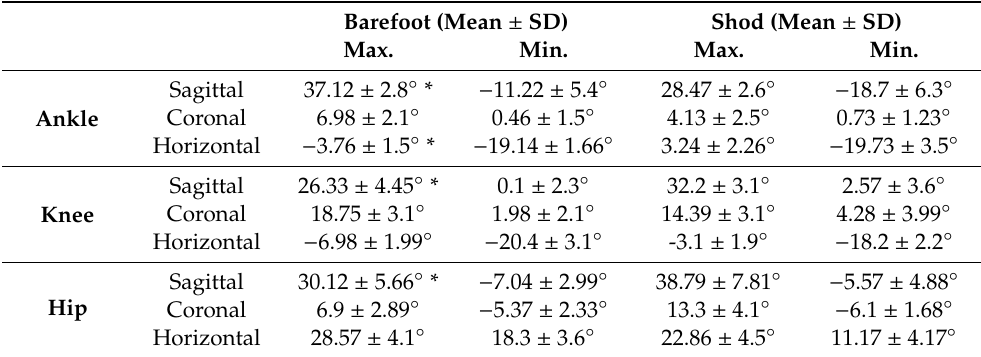
Table 2. Peak joints’ angles between barefoot and shod running during stance.